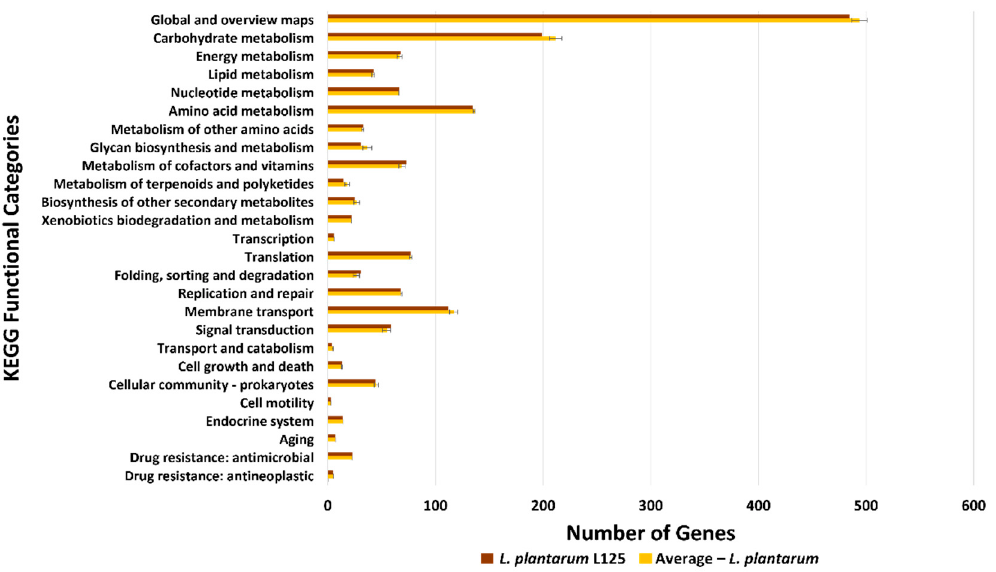
Figure 5. KEGG profiles comparison between L. plantarum L125 (Brown bars) and 21 L. plantarum strains (Yellow bars). For each one of the 21 L. plantarum strains, the number of genes in each KEGG functional category was determined, and average values were calculated (Yellow bars). The values are depicted as mean ± standard deviation.